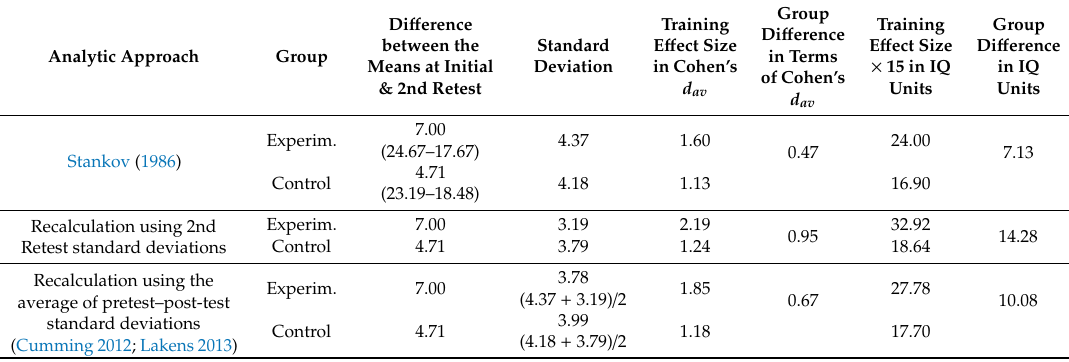
Table 1. Di ff erences between the Initial (age 15) and 2nd Retest (age 19) over 28 cognitive